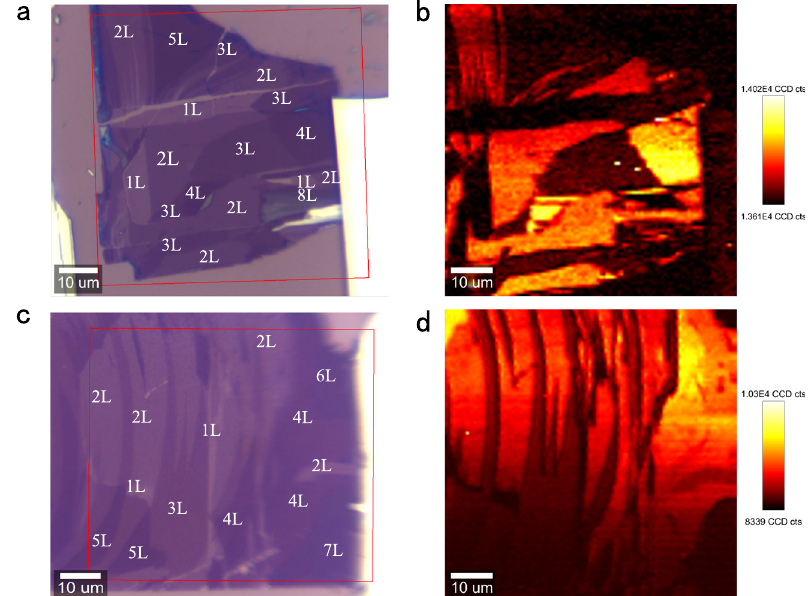
Fig. 3 SHG spatial mapping of few-layer PdSe 2 . a , c The optical images of the PdSe 2 fl akes for the SHG characterization. The red boxes indicate the selected area for the SHG measurements. The layer numbers are labeled by the white numbers. The region elected in a contain 1 – 5 L and 8 L PdSe 2, and the area selected in c includes 1 – 7 L PdSe 2 , ensuring suf fi cient sampling. The PdSe 2 samples were excited by 800 nm wavelength using 50× objective with a NA value of 0.55. b , d The spatial mapping of the integrated SHG signals corresponding to the regions in a and c , respectively. The intensities of the SHG signals are different for different layers. The SHG signal is almost absent in the odd-layer PdSe 2 , while it is strong in the even-layer PdSe 2 . The color bars are shown on the right of the fi number, the spatial mapping was implemented. The red box in Fig. 3a indicates the scanning regions of the sample, containing 1 – 5 L, 8 L, and bulk PdSe 2 fl akes. Clearly, the SHG signals from